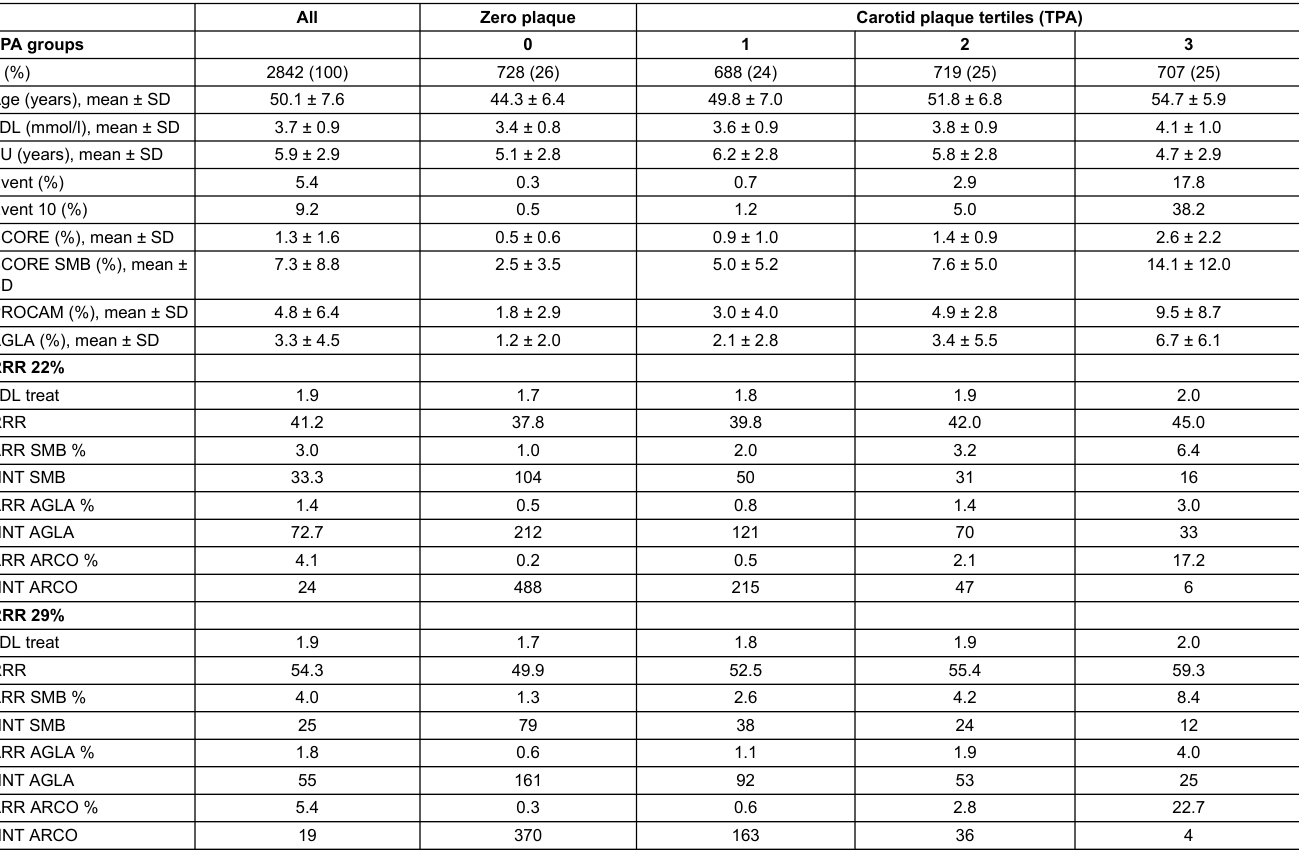
Table 5: Characteristics of patients stratified by atherosclerosis presence (TPA tertiles), effect of statin therapy (with relative risk reduction of 22% and 29%), 50% LDL lowering for daily costs of CHF 1.00 and numbers needed to treat for various risk scores and 10-year risk derived from TPA. All Zero